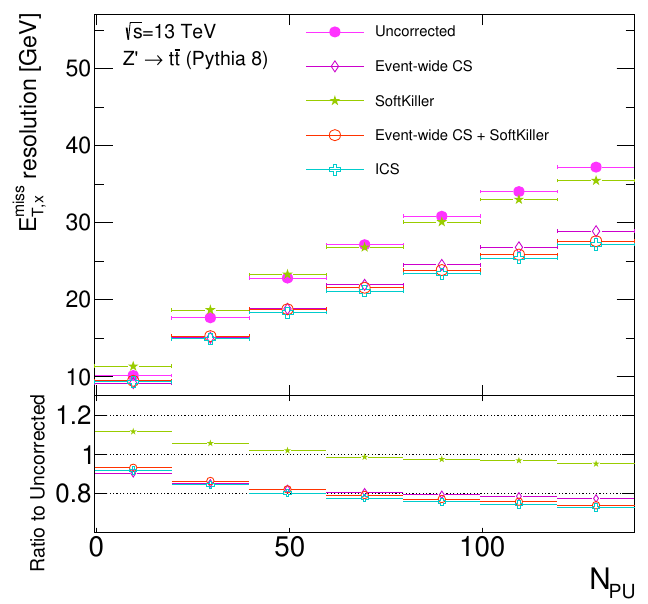
Figure 6. Resolution of the x -component of the ~E miss